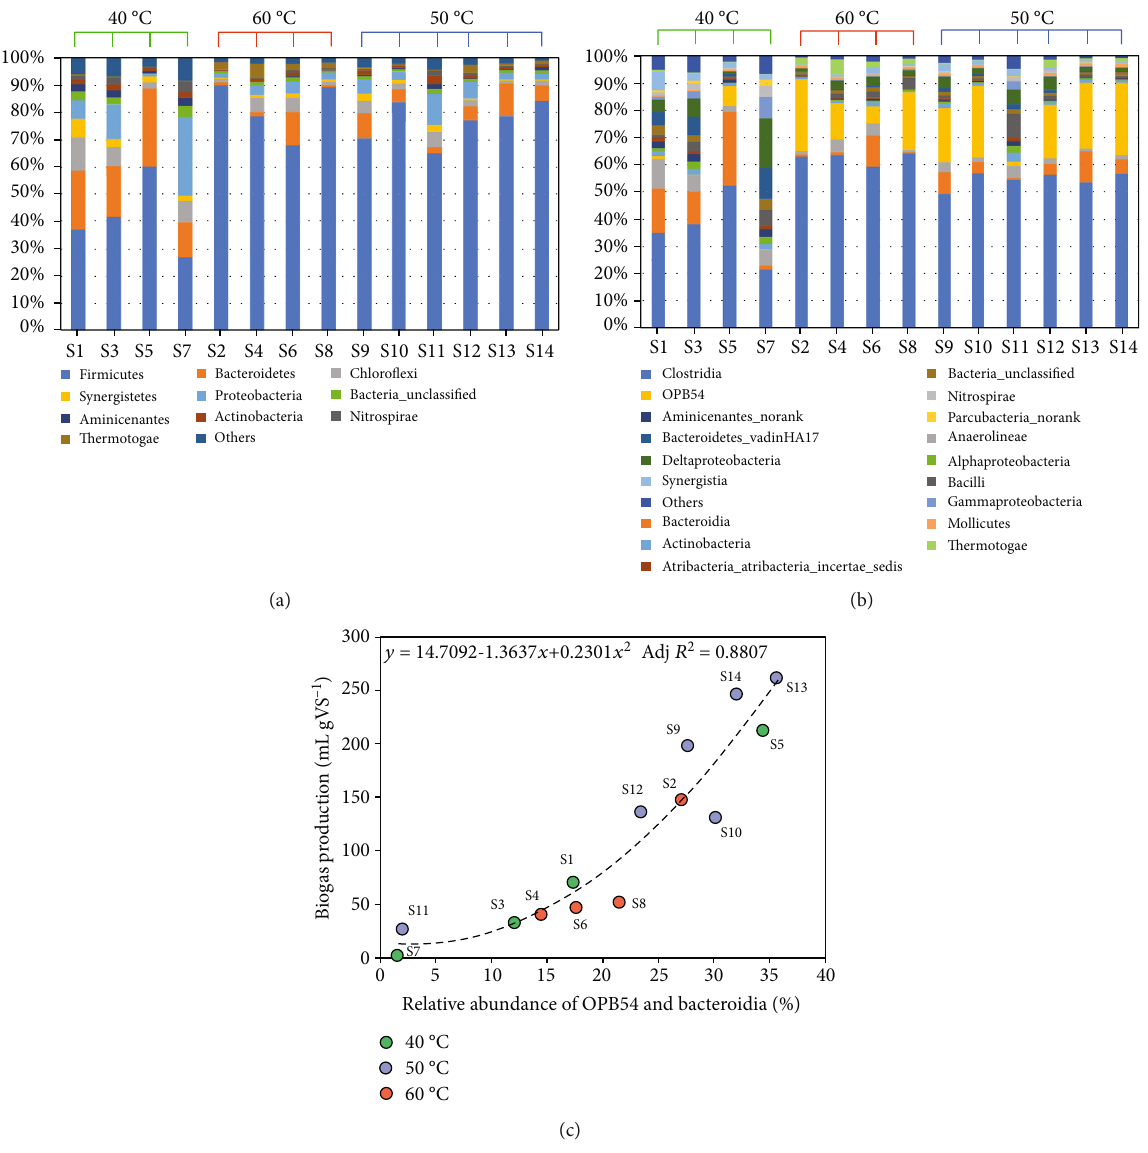
Figure 4: Major bacterial phyla (each represented by > 1% total sequences in at least one sample) (a), relative abundance (% of the total bacterial sequences in each sample) of the major OTUs (b), and relationship between biogas production and relative abundance of OPB54 and Bacteroidia (c) after 20 d of